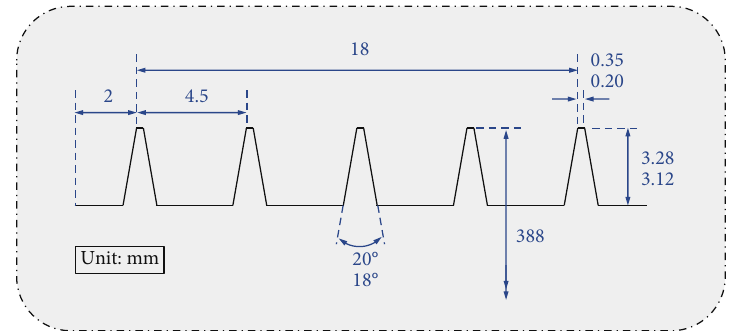
Figure 5: Test con fi guration [27].